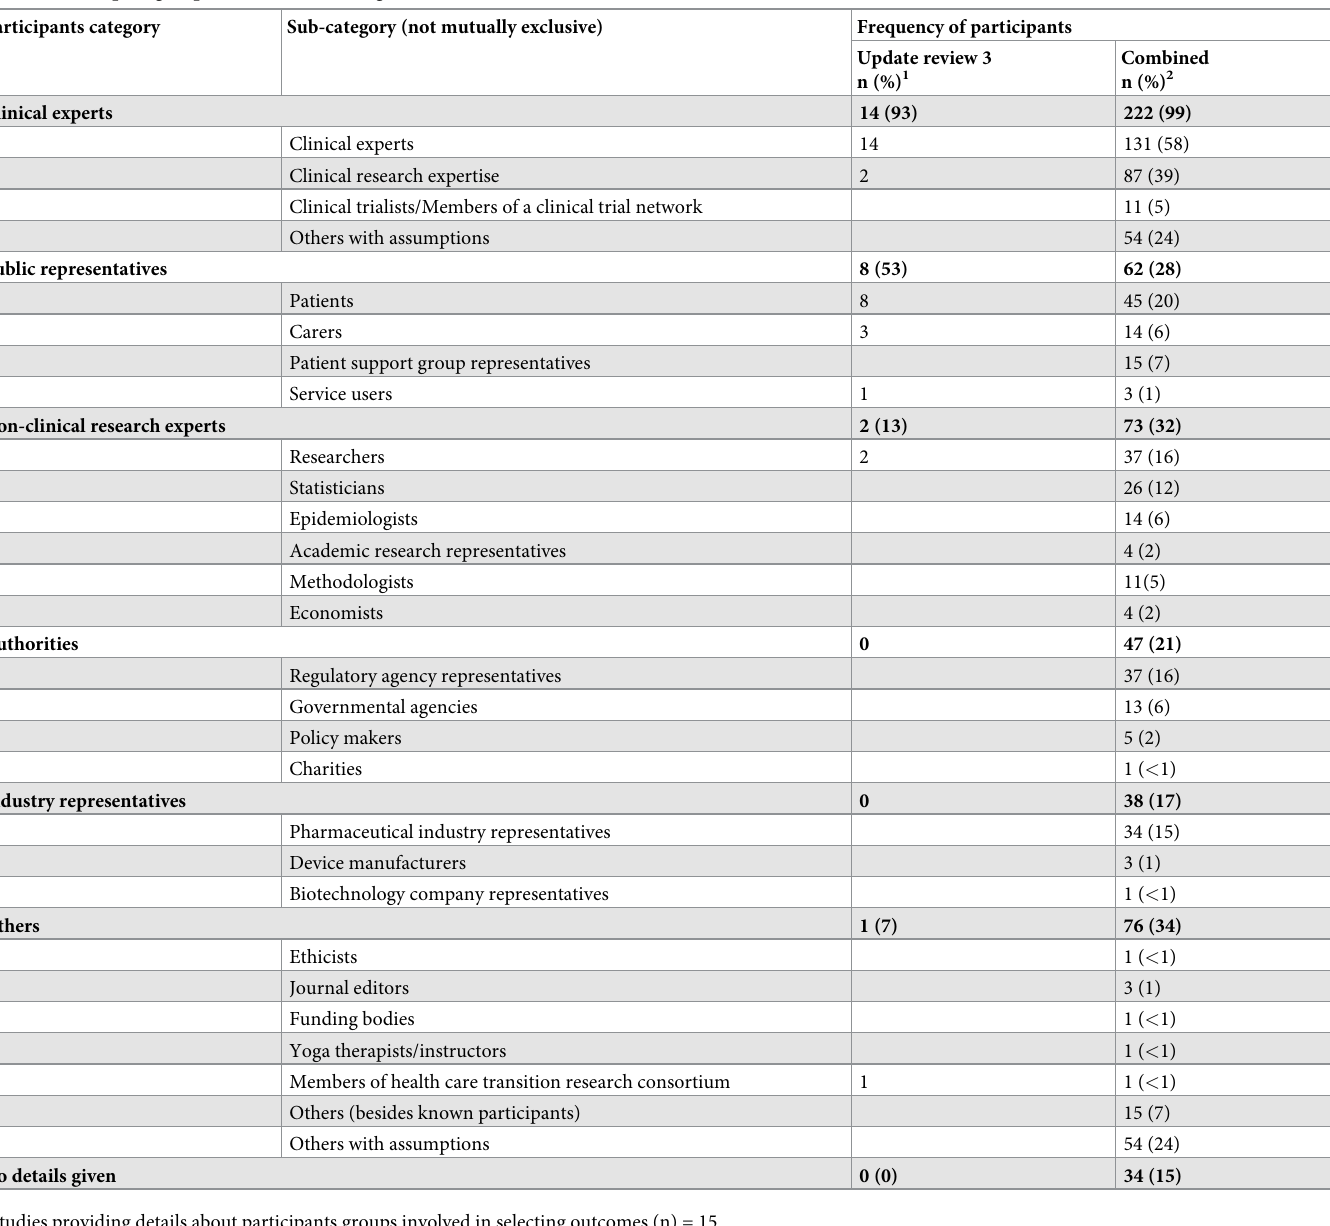
Table 4. Participant groups involved in selecting outcomes for inclusion in COS (n =